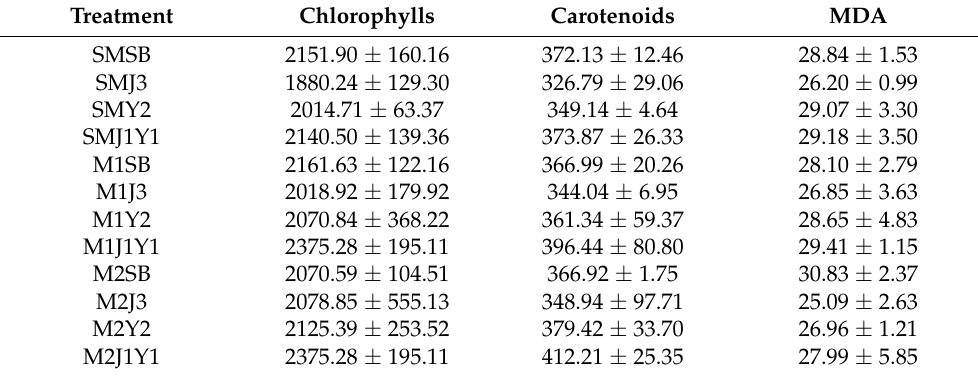
Table 1. Mean and standard deviation for the biochemical variables: total contents of chlorophylls combination of inoculation (SM: Non inoculated, M1: Claroideoglomus claroideum , Claroideoglomus etunicatum ; Diversispora spurca , Funneliformis mosseae , and Rhizophagus intraradices ; M2: Claroideoglomus claroideum , Claroideoglomus etunicatum , Funneliformis constrictum , Funneliformis mosseae , and Rhizopha- gus clarus ) and biostimulant foliar applications (SB: Seedlings sprayed with only water, J3: seedlings sprayed with Larrea divaricata (3% w / v ), Y2: seedlings sprayed with Ilex paraguariensis (2% w / v ), and J1Y1: mixture of both biostimulants (1% w / v : 1% w / v ). Stars indicate the significance level. Significance levels: *** <0.001; ** <0.01; * <0.05;